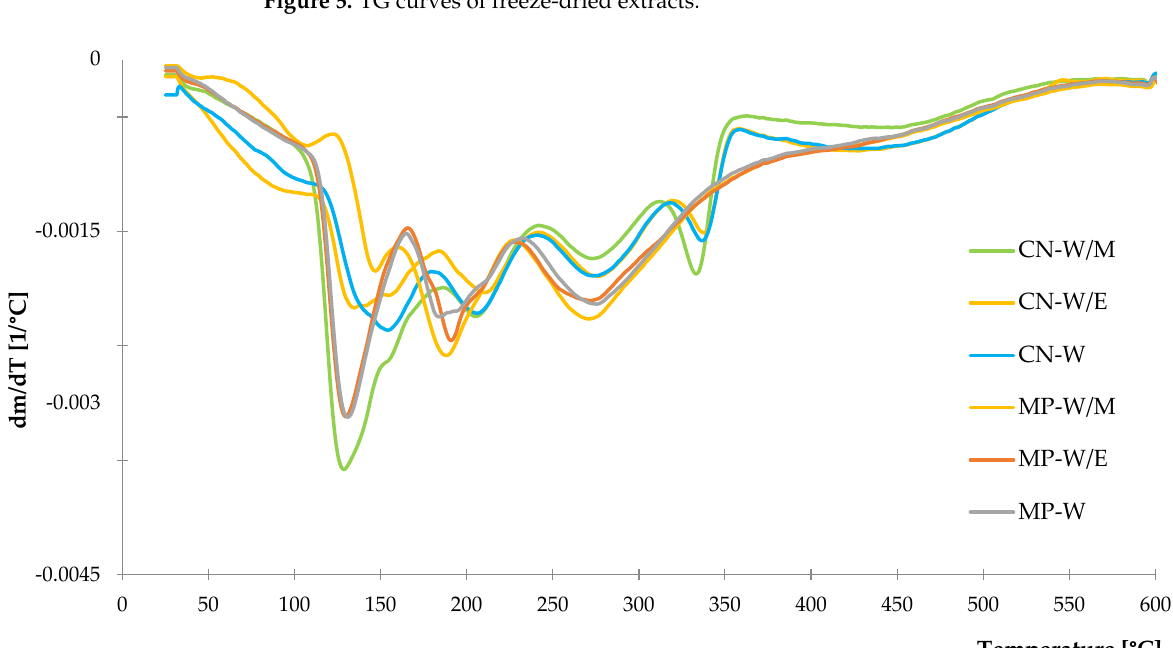
Figure 5. TG curves of freeze-dried extracts.